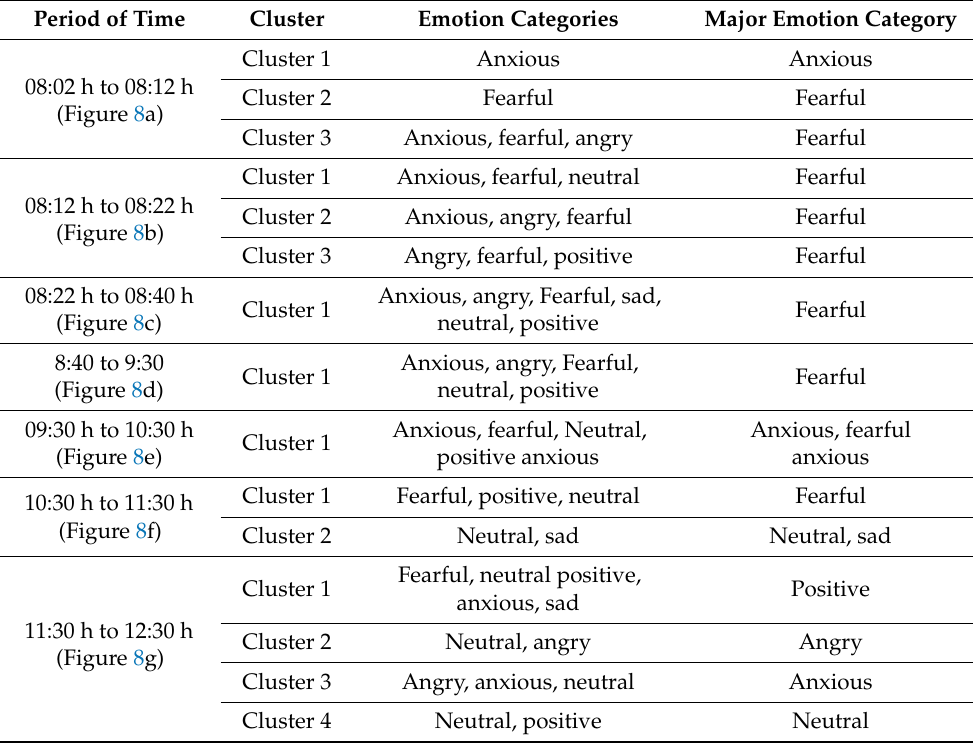
Table 1. Distribution characteristics of emotions in different clusters in different time